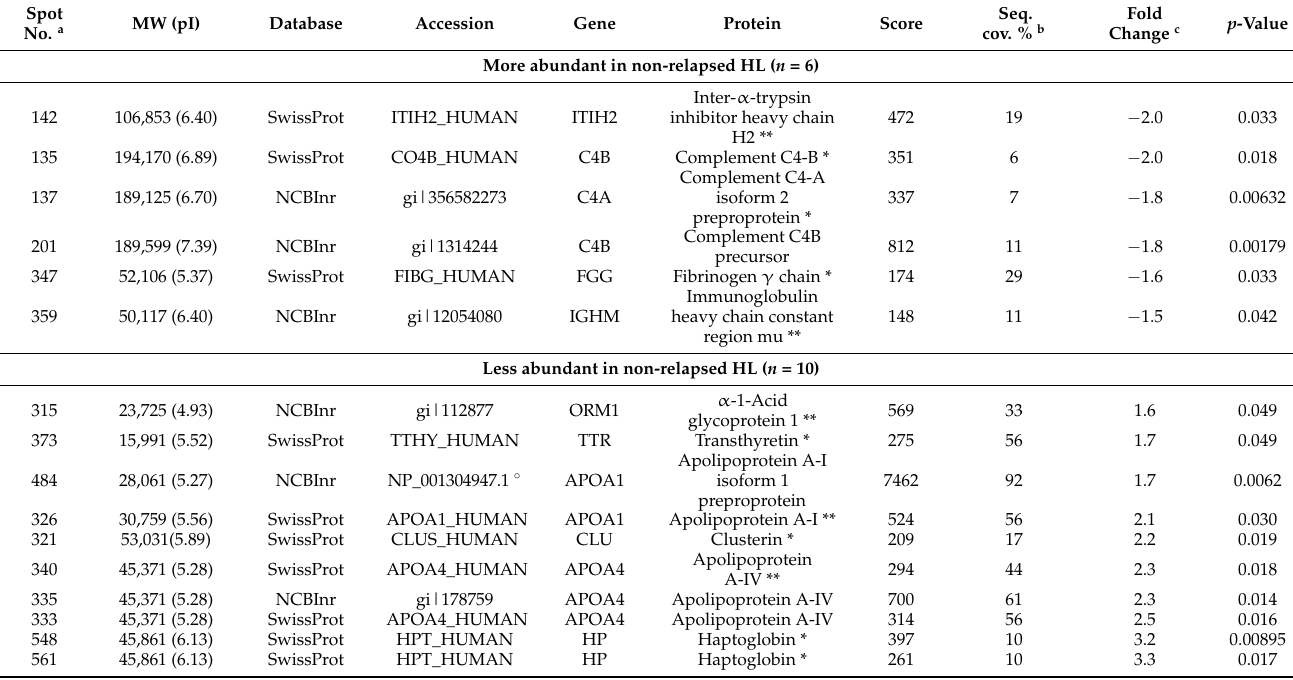
Table 2. Differentially abundant proteins in plasma-derived EVs between patients with non-relapsed and relapsed pediatric HL of the explorative groups.